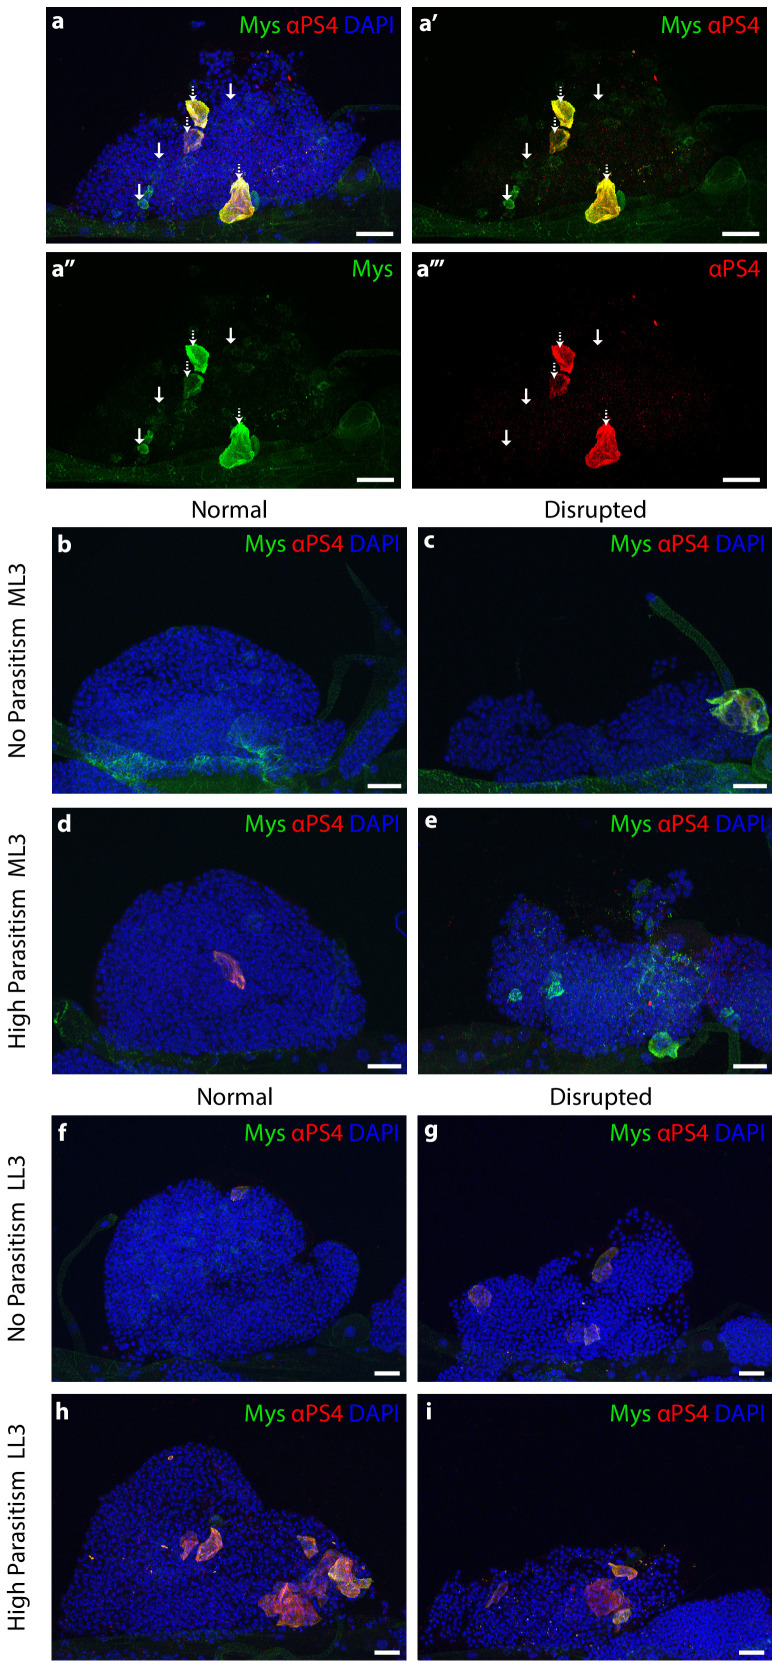
Lamellocytes differentiation state and morphology of anterior lymph gland lobes.(a) Anterior lobe of a lymph gland from a larva from No Parasitism selection regime. Immature lamellocytes are stained with Myspheroid (Mys, green, with arrow). Mature lamellocytes are double stained with Mys and Integrin alpha PS4 subunit (α-PS4, red, white-dotted arrow). (b,c) No Parasitism anterior lobe in mild larval stage 3; normal (b) and disrupted lobe (c). (d,e) High parasitism anterior lobe in mild larval stage 3; normal (d) and disrupted lobe (e). (f,g) No parasitism anterior lobe in late larval stage 3; normal (f) and disrupted (g). (h,i) High parasitism anterior lobe in late larval stage 3; normal (i) and disrupted (j). All samples were stained with Mys (green), α-PS4 (red). Nuclei were stained with DAPI. Scale bars = 20 µm.